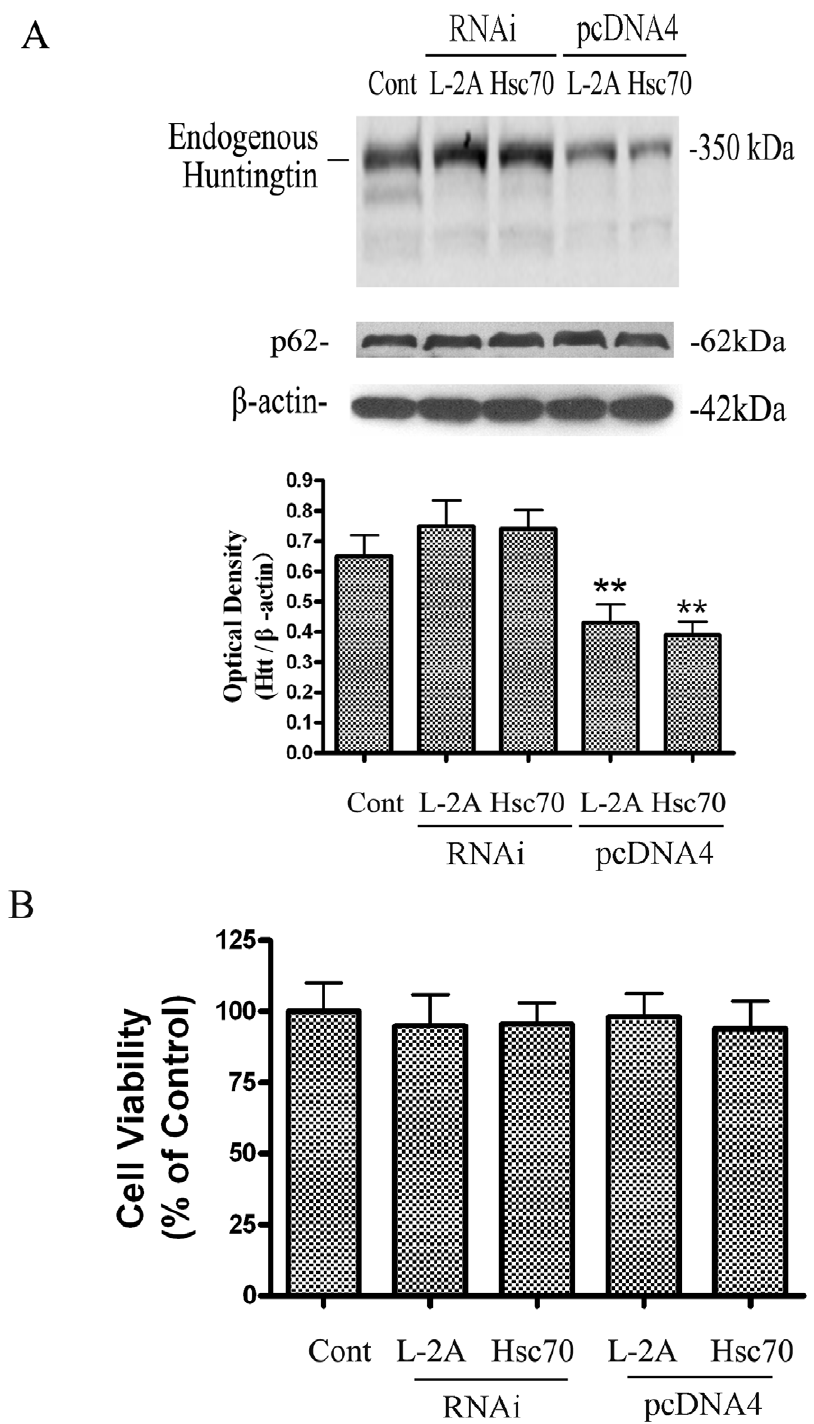
Figure 8. The effects of CMA on degradation of endogenous Htt. (A) The effects of knockdown and overexpression of LAMP-2A and Hsc70 on endogenous Htt and p62. PC12 cells were transiently transfected with LAMP-2A, Hsc70 plasmid, vector control or LAMP-2A and Hsc70 siRNA for 48 h. Lysates were subjected to Western blot analysis with antibodies against Htt and p62. Values are the mean 6 SE of three independent experiments. **P , 0.01 (compared with endogenous Htt without treatment). (B) The PC12 cell viability following change of CMA. Following knockdown or overexpression of LAMP-2A and Hsc70 for 48 h, cell viability was analyzed with the MTT assay. Values were given as mean 6 SD of three independent experiments.